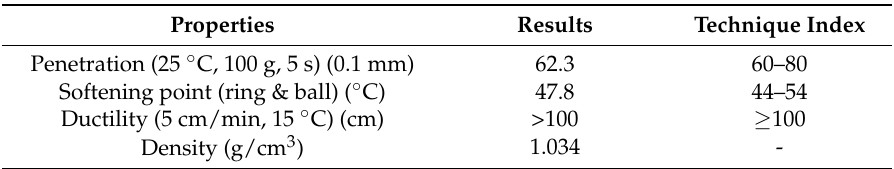
Table 1. Properties of 70 # base